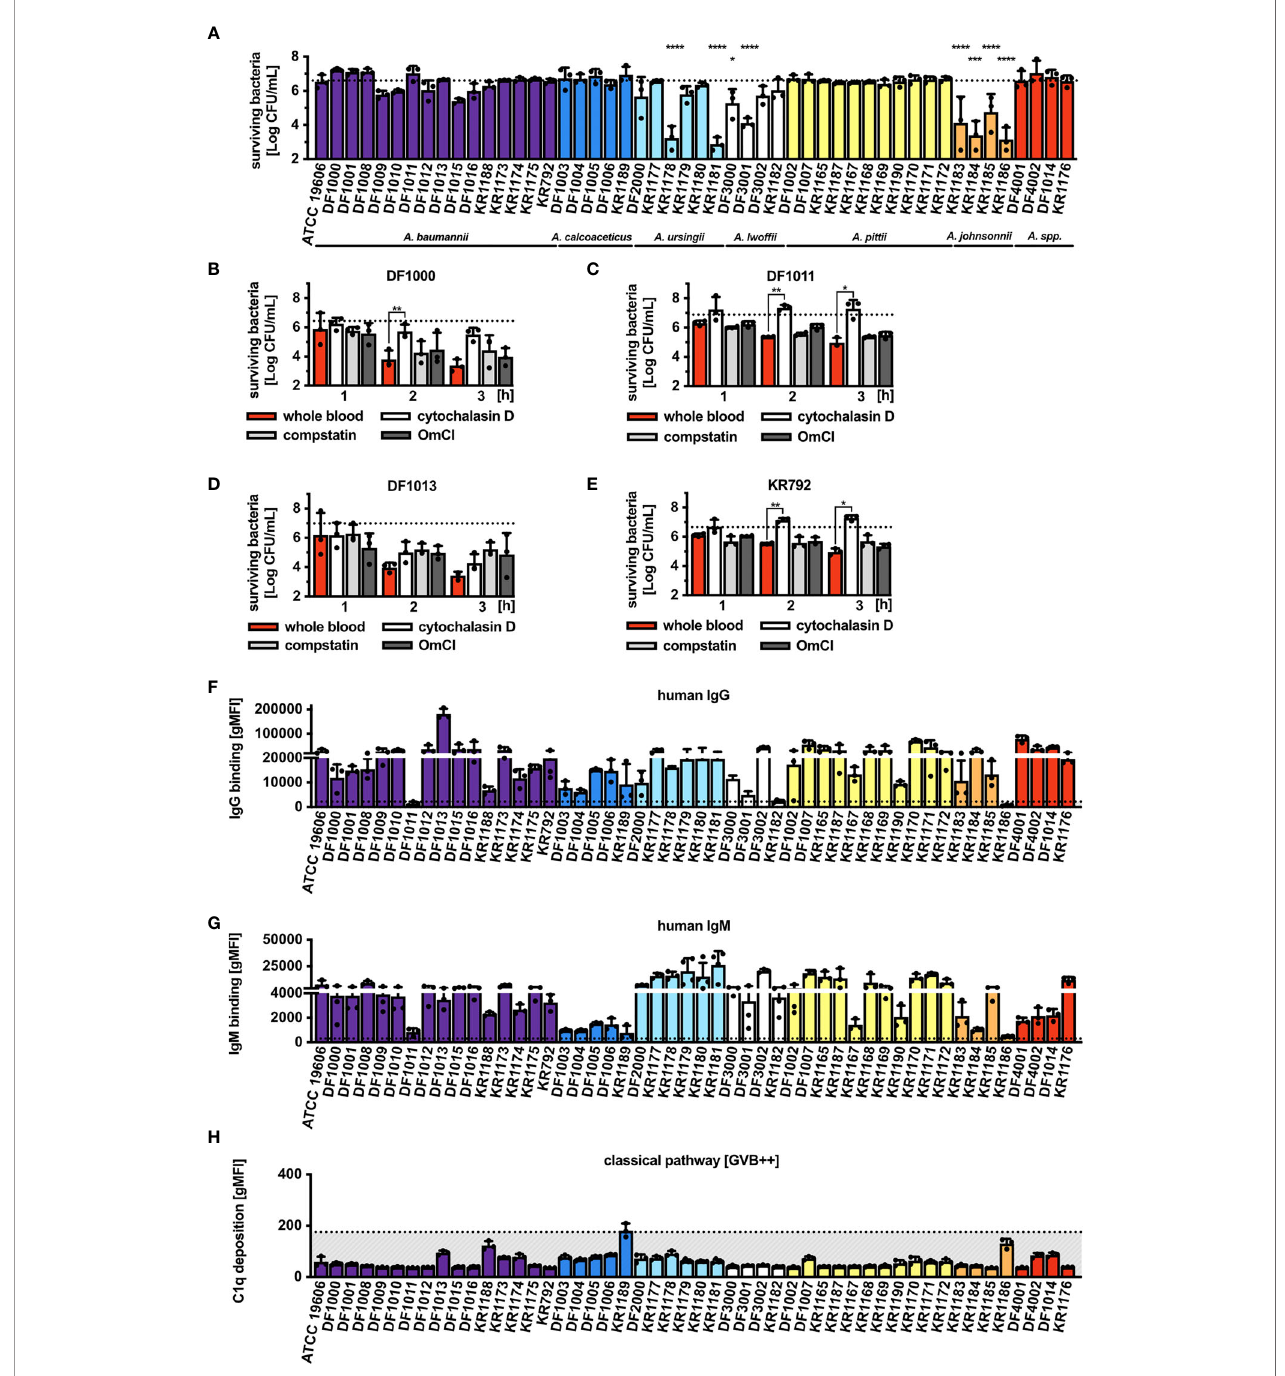
FIGURE 1 | Survival of Acinetobacter isolates in human serum and blood, and recognition by the complement system. (A) Survival of Acinetobacter isolates in the presence of 30% NHS. Survival of isolates (B) A. baumannii DF1000, (C) A. baumannii DF1011, (D) A. baumannii DF1013 and (E) A. baumannii KR792 in human blood. Survival of bacteria was analyzed as CFU/mL, bars represent mean ± SD of at least 3 independent experiments. Horizontal dotted line refers to the starting number of bacteria used in the assay. One-way ANOVA with Dunnett ’ s post-test was used to analyze results from bactericidal activity assays, considering input as a control sample. Two-way ANOVA with Dunnett ’ s post-test was used to analyze results from blood killing assay, considering sample with full blood as a control sample. * p < 0.05, ** p < 0.01, *** p < 0.005, and **** p < 0.0001. Recognition of Acinetobacter by human (F) IgG and (G) IgM antibodies. (H) Deposition of C1q on bacterial surface. (F – H) Bars represent gMFI ± SD of at least 3 independent experiments; horizontal dotted line represents gMFI (average + SD) measured in human IgG/IgM- depleted serum or human C1q-depleted serum acting as a binding/deposition